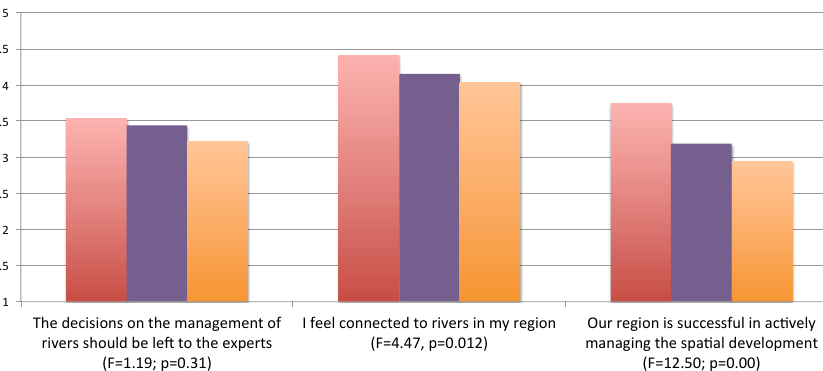
respondents from the subgroup with marginal stakeholder